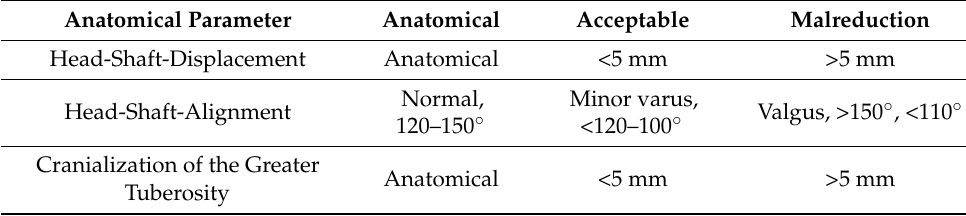
Table 1. Parameters of fracture reduction.